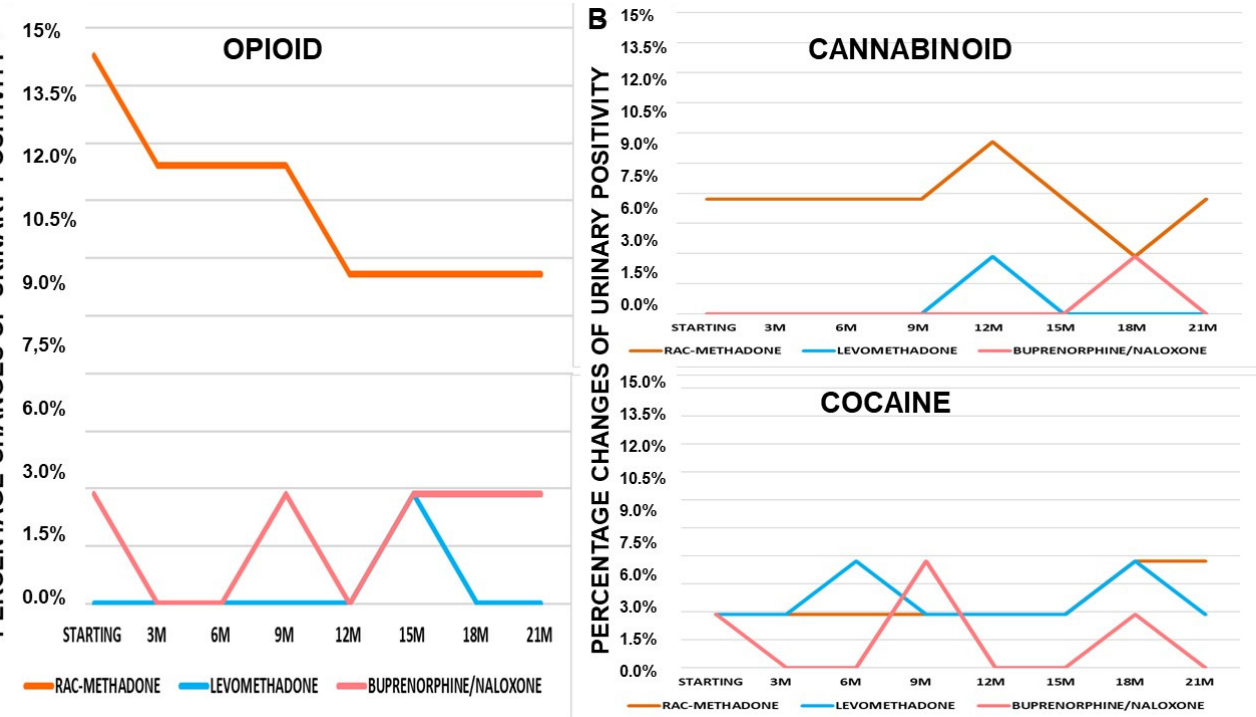
Figure 4. ( A ) Changes of opioids urinary positivity over 21 months (21M) of treatments. ( B ) Changes of cannabinoids urinary positivity over 21 months (21M) of treatments. Changes of cocaine urinary positivity over 21 months (21M) of treatments.